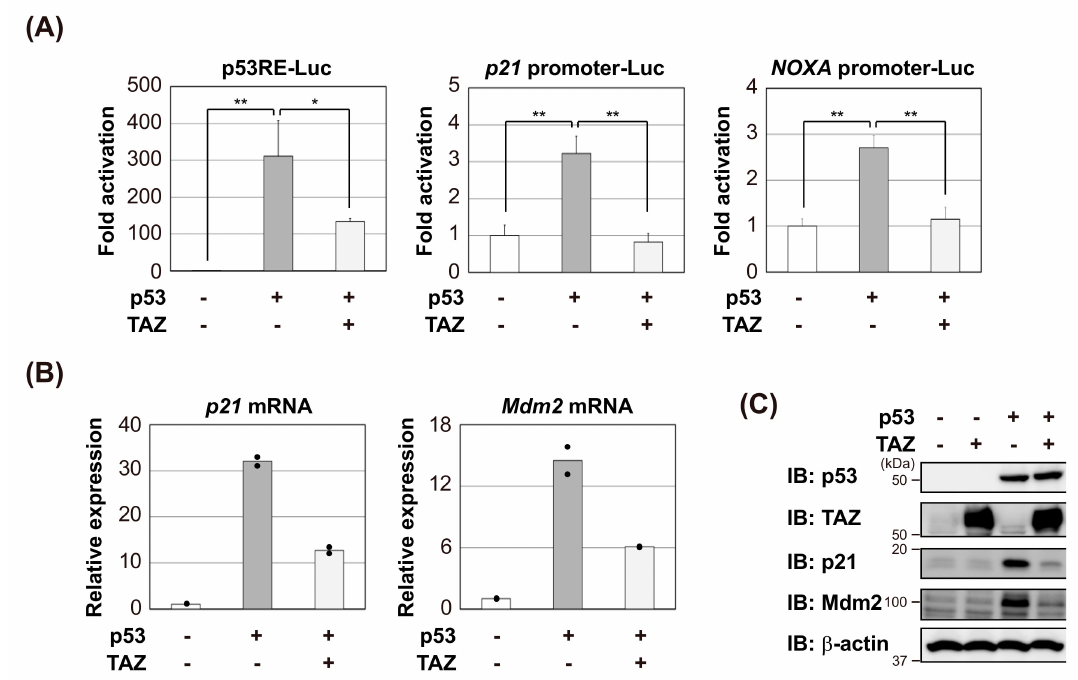
Figure 1. TAZ represses the transcriptional activity of p53. ( A ) H1299 cells were transfected with the indicated reporter plasmids and pCMV / β -gal in combination with the indicated constructs. After 24 h, luciferase activity in cell lysates was measured and normalized with β -gal activity. Experiments were performed in triplicate, and data are represented as mean activation fold ± S.D. ( B , C ) H1299 cells were transfected with p53 in the absence or presence of TAZ. After 18 h, p53 target genes expression levels were analyzed by RT-qPCR (duplicate determination) ( B ) or immunoblotting ( C ). Significant di ff erences are indicated as ** p < 0.01 and * p <